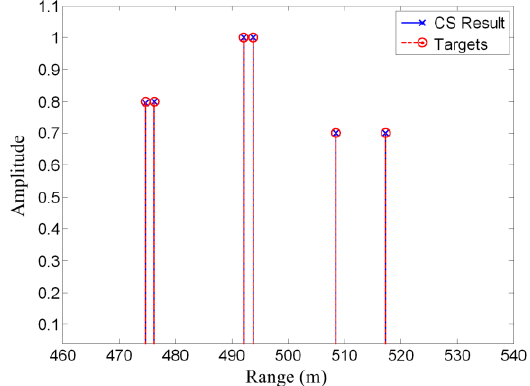
Figure 3. Compressed sensing example; closely spaced targets are well resolved.